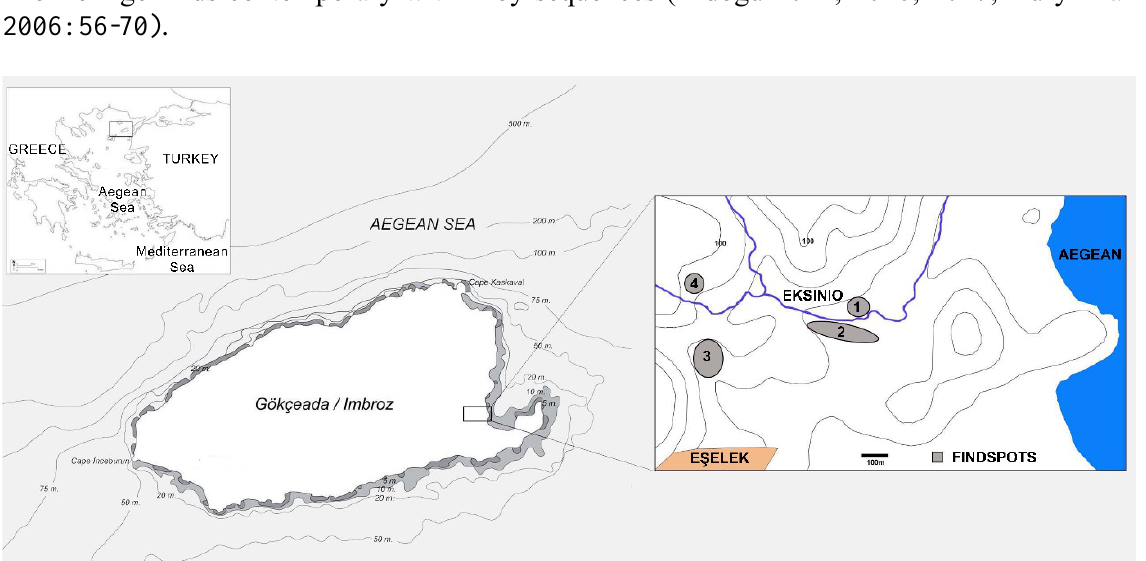
Figure 1. Map of the Eksino Region and Findspots where Palaeolithic finds were discovered in the east of Gökçeada